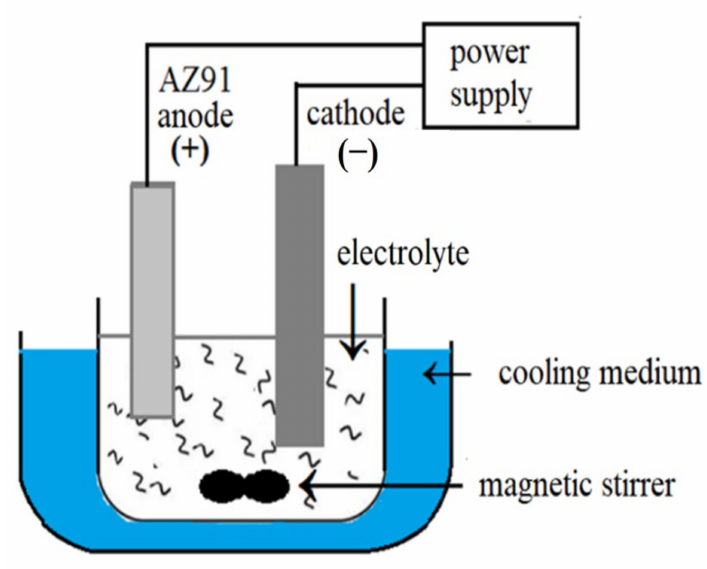
Figure 1. Equipment set-up for PEO